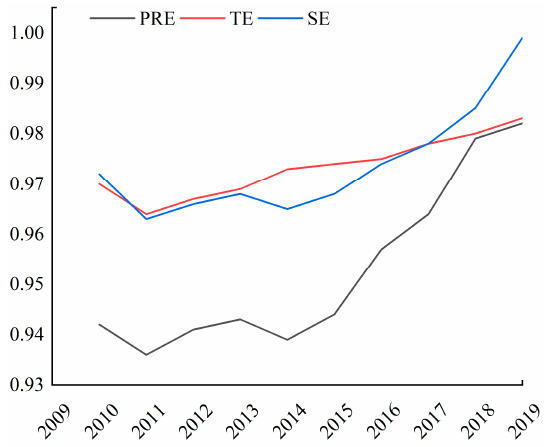
Figure 2. Change trend of the subdimensions of PRE for 2010–2019.